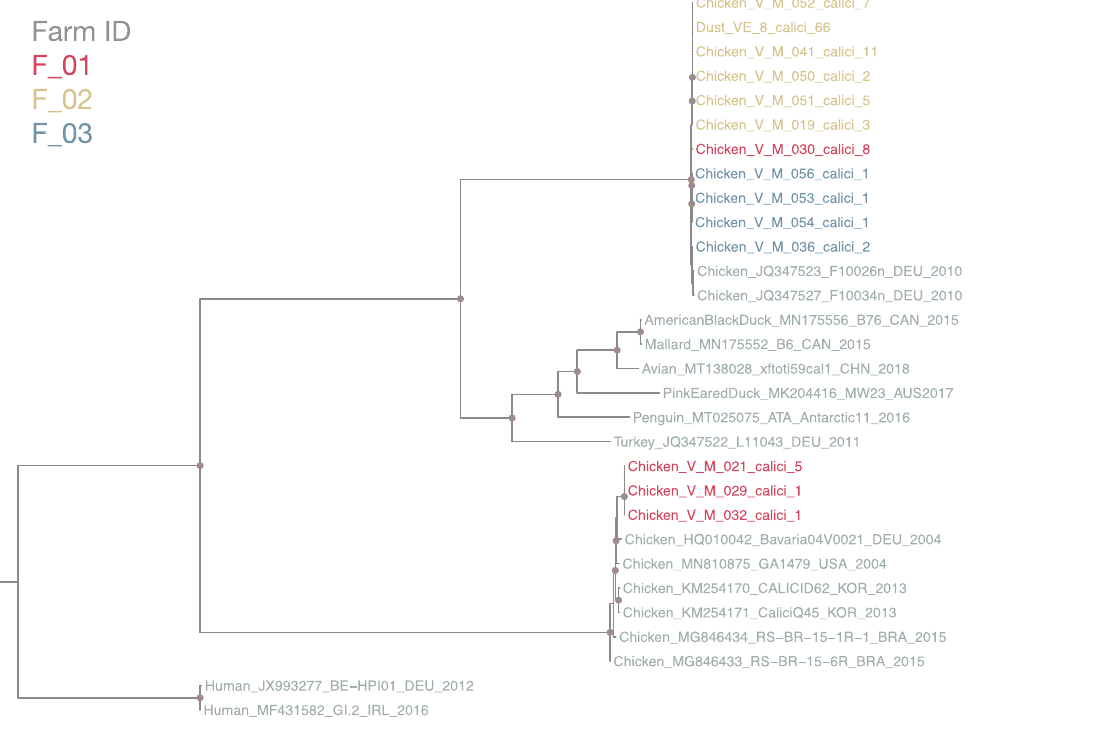
Figure 6. Maximum-likelihood phylogenetic tree of 30 calicivirus partial polyprotein amino acid sequences (sequences from this study: 14; reference sequences: 16; 2794 sites) reconstructed using a best-fit evolutionary model LG + FC + R10. For clarity, only bootstrap supports > = 70 are shown as a light brown node point. Tip labels of our samples are color-coded by corresponding farm ID. Reference sequences are in grey and tree was mid-point rooted for